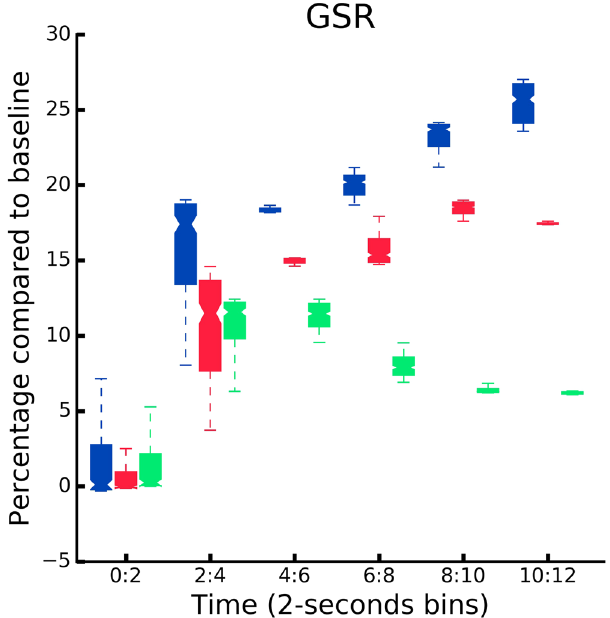
Figure 5. GSR responses per condition binned in 2.5-seconds time windows. The first bin (0–2 seconds) represents the latency of the GSR response following the threat ( time =